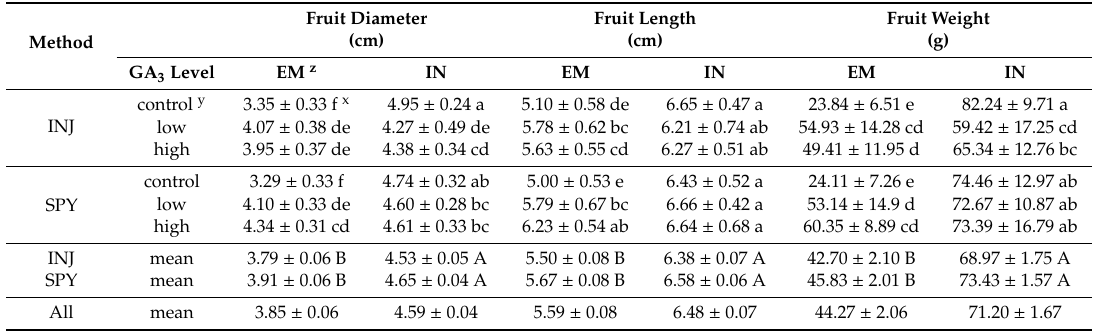
Table 1. E ff ect of gibberellic acid (GA 3 ) application treatments on fruit variables. Fruit Diameter Fruit Length Fruit Weight (cm) Method